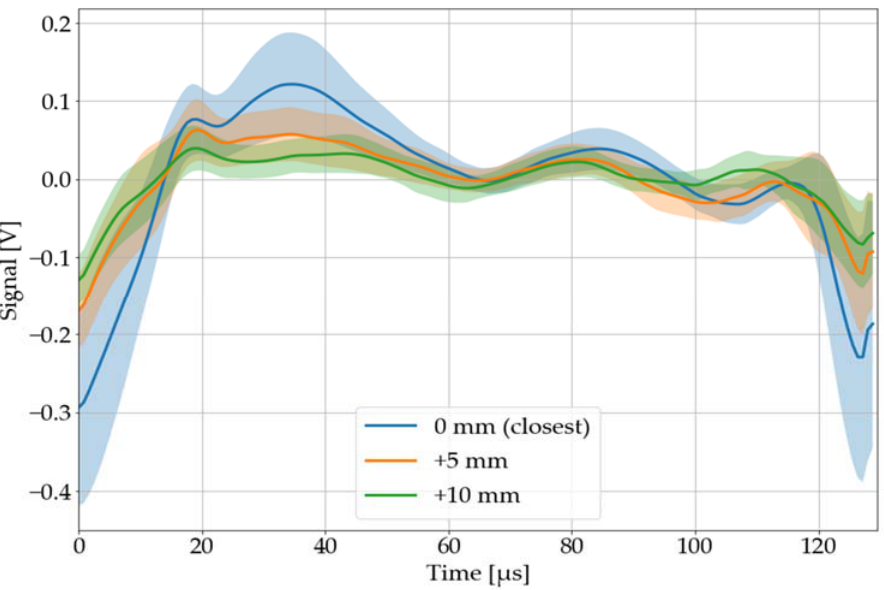
Figure 14. Recorded, processed, and averaged laser-acoustic material responses for black PVC, when the microphone positioned at an angle of 45 ◦ was moved away for 5 and 10 mm compared to its closest distance. The colored area around each graph corresponds to its 68% confidence